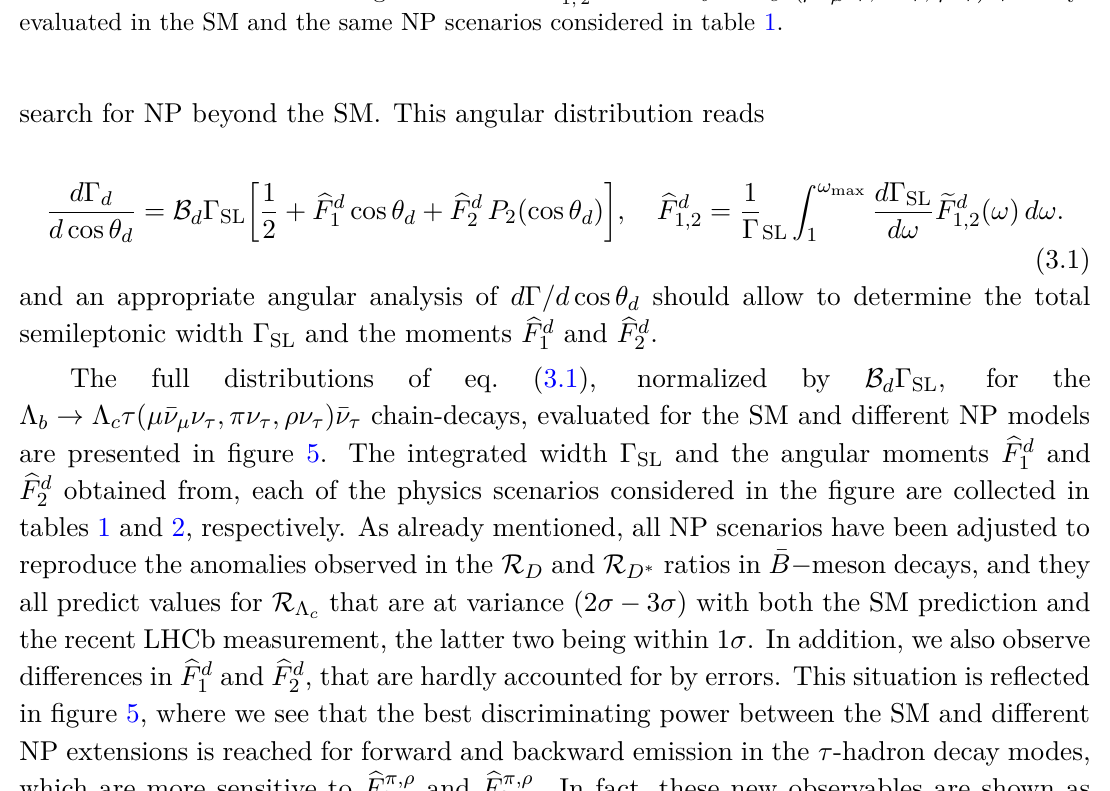
for the Λ b → Λ c τ ( µ ¯ ν µ ν τ , πν τ , ρν τ )¯ ν τ decays 1 , 2